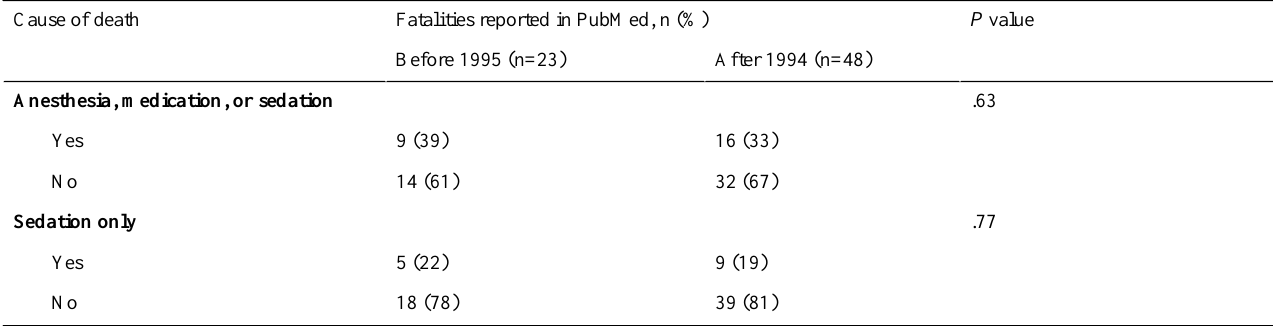
Table 10. Comparison of fatalities in dental facilities described in PubMed before 1995 and after 1994 with respect to deaths assigned to the anesthesia, medication, or sedation and sedation-only categories.